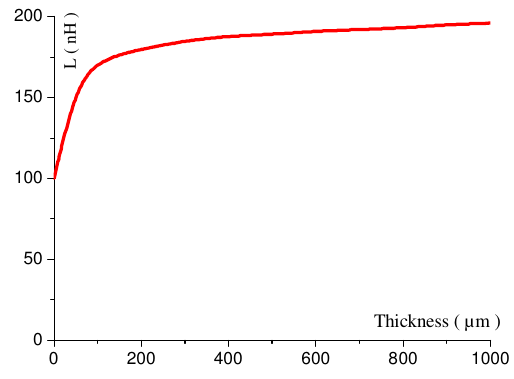
Figure 6: Variation of the inductance as a function of the magnetic material thickness.